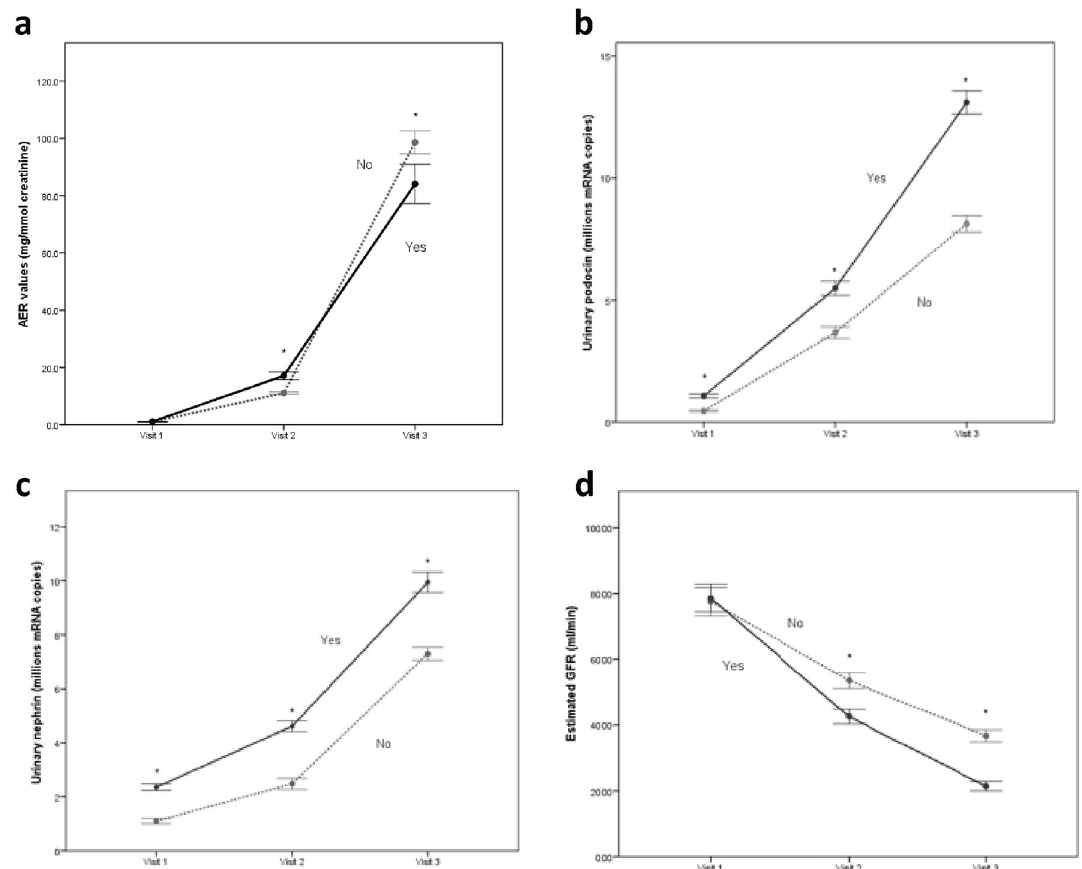
Figure 1. Alteration in urinary biomarkers sampled at different visits. Values for AER ( a ) urinary podocin ( b ) urinary nephrin ( c ) RNA copies and estimated GFR (CKD-epi equation; d ) across Visits 1–3 in Type II diabetic subjects who developed (Yes; solid line) and did not develop (No; dotted line) CVD. *: statistically different (see text for